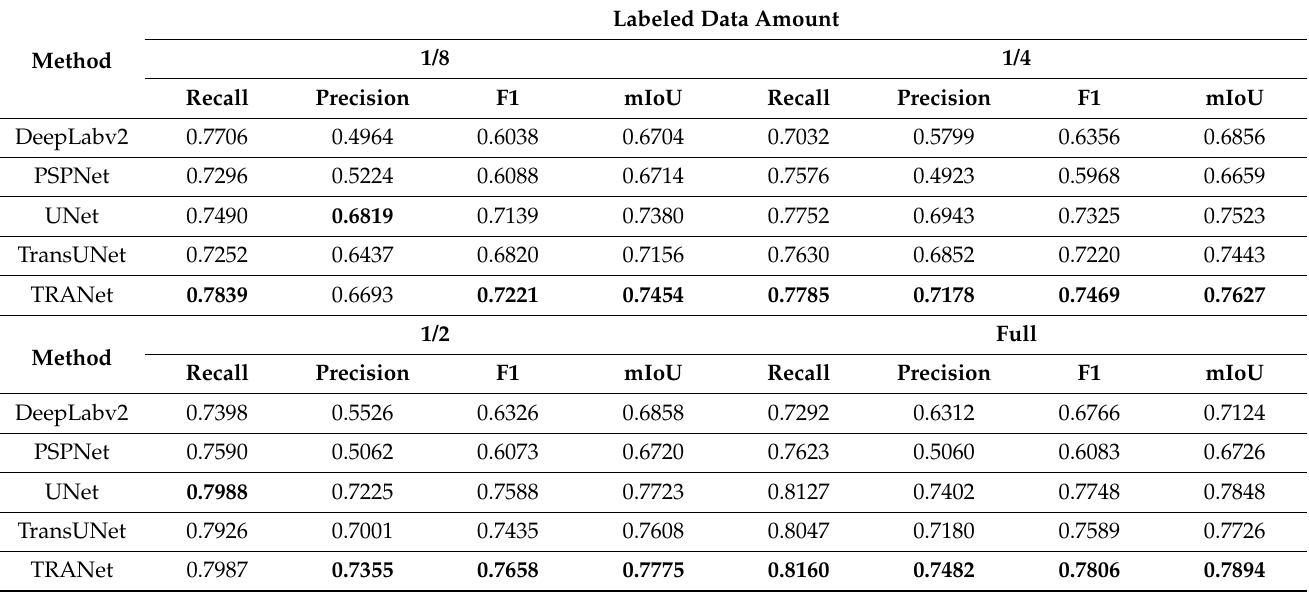
Table 3. Building extraction accuracies obtained with different quantities of labeled data on the MBD. The highest accuracy is displayed in bold.